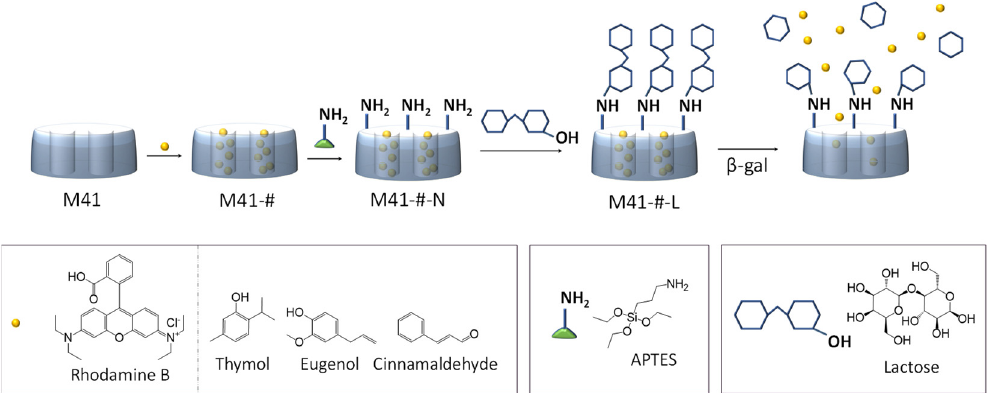
Scheme 1. Representation of the M41-EOC-L synthesis process and subsequent cargo delivery performance under β -gal enzymatic action. enzymatic action.